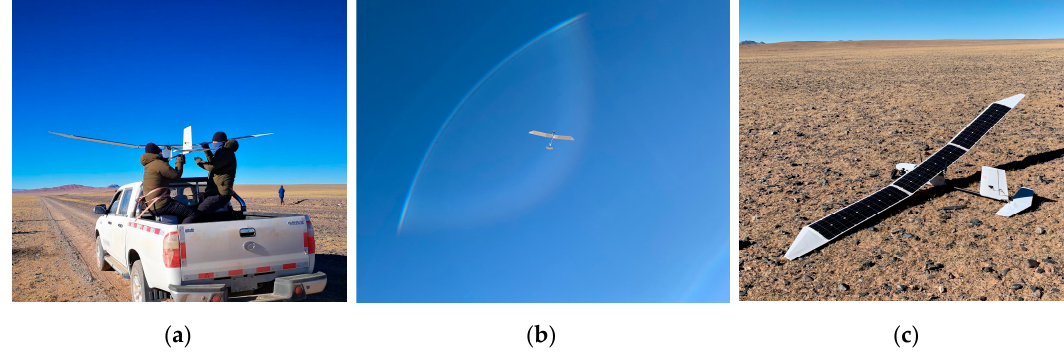
Figure 16. The high-altitude field experiment of UAV in Qiangtang, Tibet: ( a ) Vehicle-mounted takeoff, ( b ) cruise phase for mission, ( c ) hard landing in extreme environment.